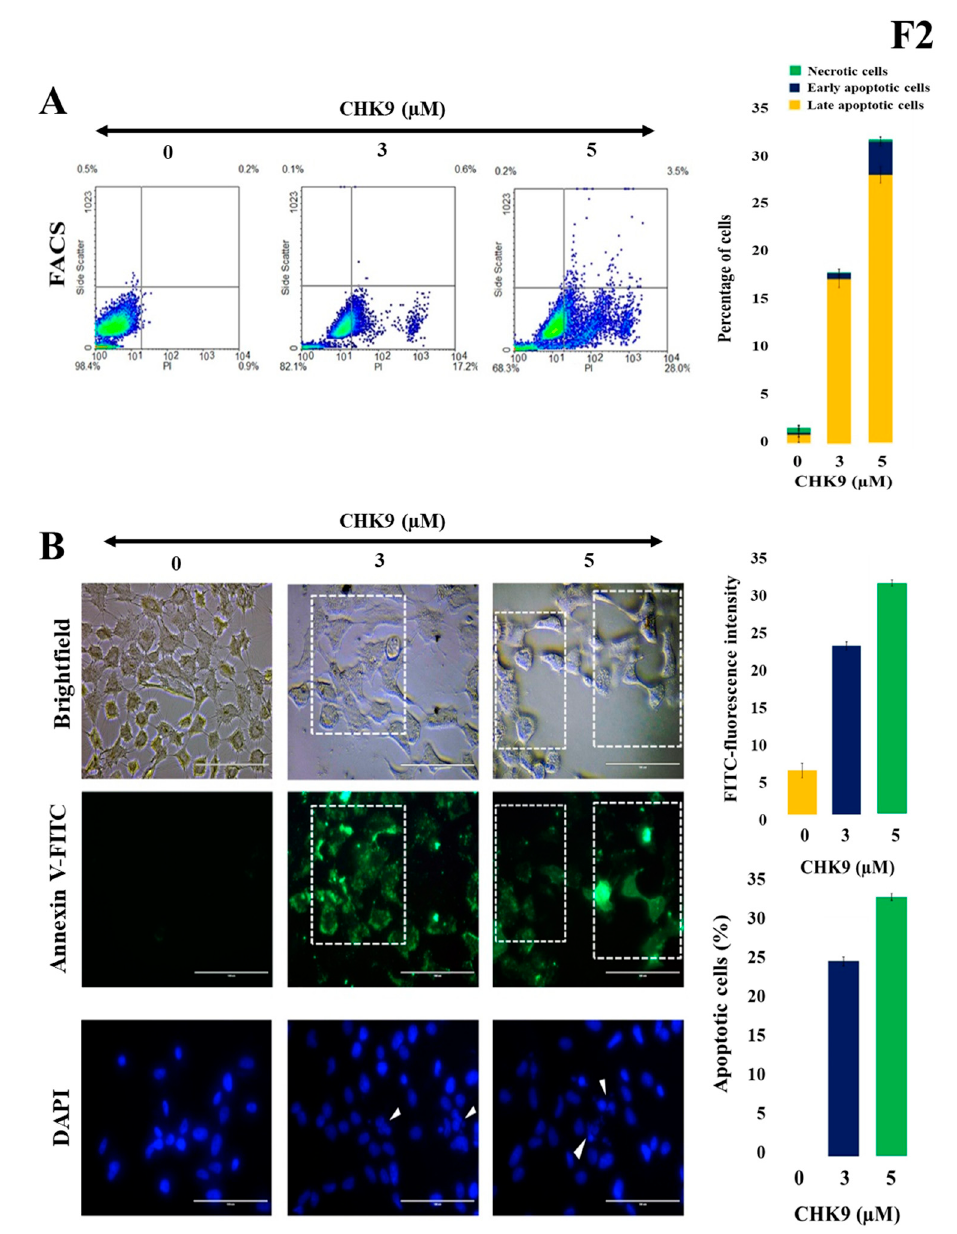
Figure 2. CHK9 induces apoptosis in lung cancer cells. The A549 cells were treated with CHK9 at 0, 3 and 5 µ M for 48 h and used for further experiments. ( A ) Densitometric plot with a graphical representation of apoptotic cells / necrotic cells. ( B ) Annexin V immune staining images of bright field and fluorescent images and condensed nuclear changes in DAPI stained images (Magnification: 20 ×). The cells with shrunken or fragmented nuclei with condensed chromatin were indicated using white arrowheads.